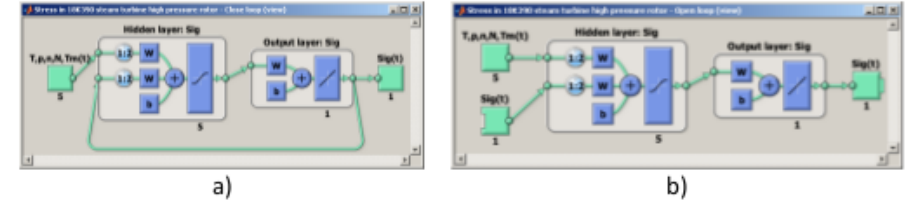
Figure 3: MATLAB implementation of NARX neural network responsible assessment of critical point stress: (a) parallel architecture, (b) se- ries parallel architecture.